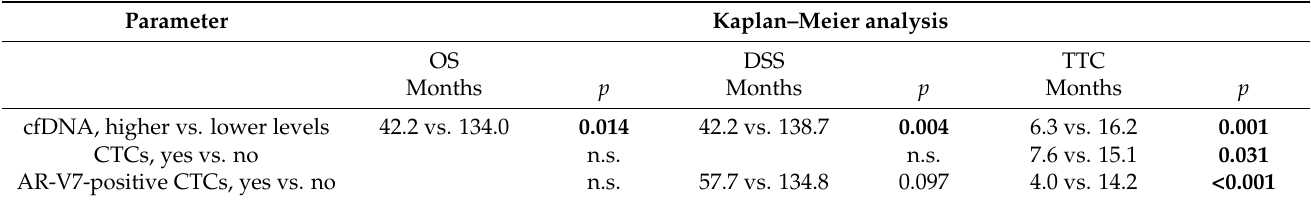
Table 4. Kaplan–Meier analysis: association of cfDNA levels, CTCs, or AR-V7-positive CTCs with prognosis. Parameter Kaplan–Meier analysis OS DSS TTC Months p Months p Months p cfDNA, higher vs. lower levels 42.2 vs. 134.0 0.001 CTCs, yes vs. no n.s. AR-V7-positive CTCs, yes vs.